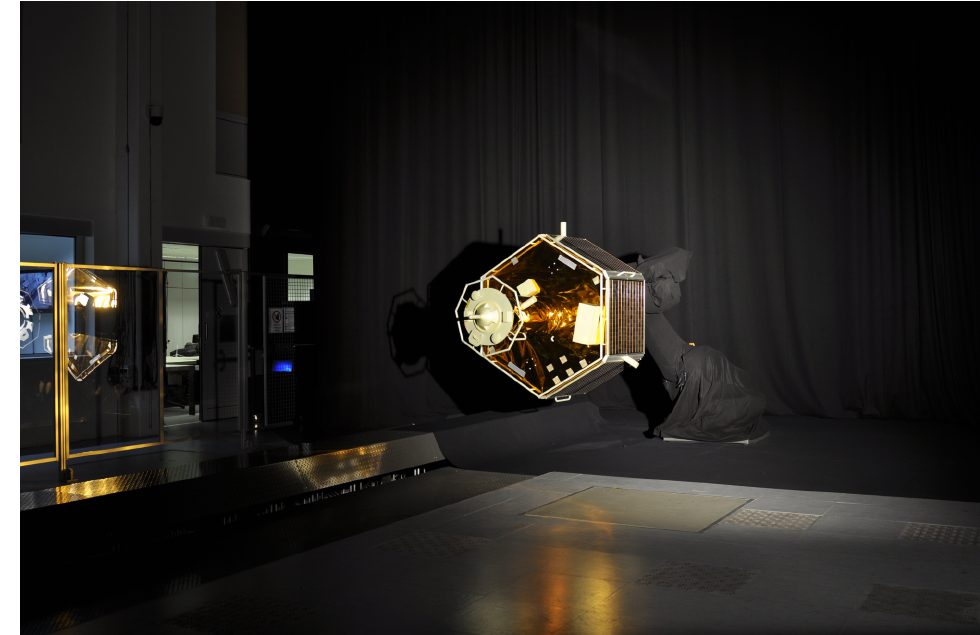
Figure 15. Background curtain and robot covered in molton cloth.